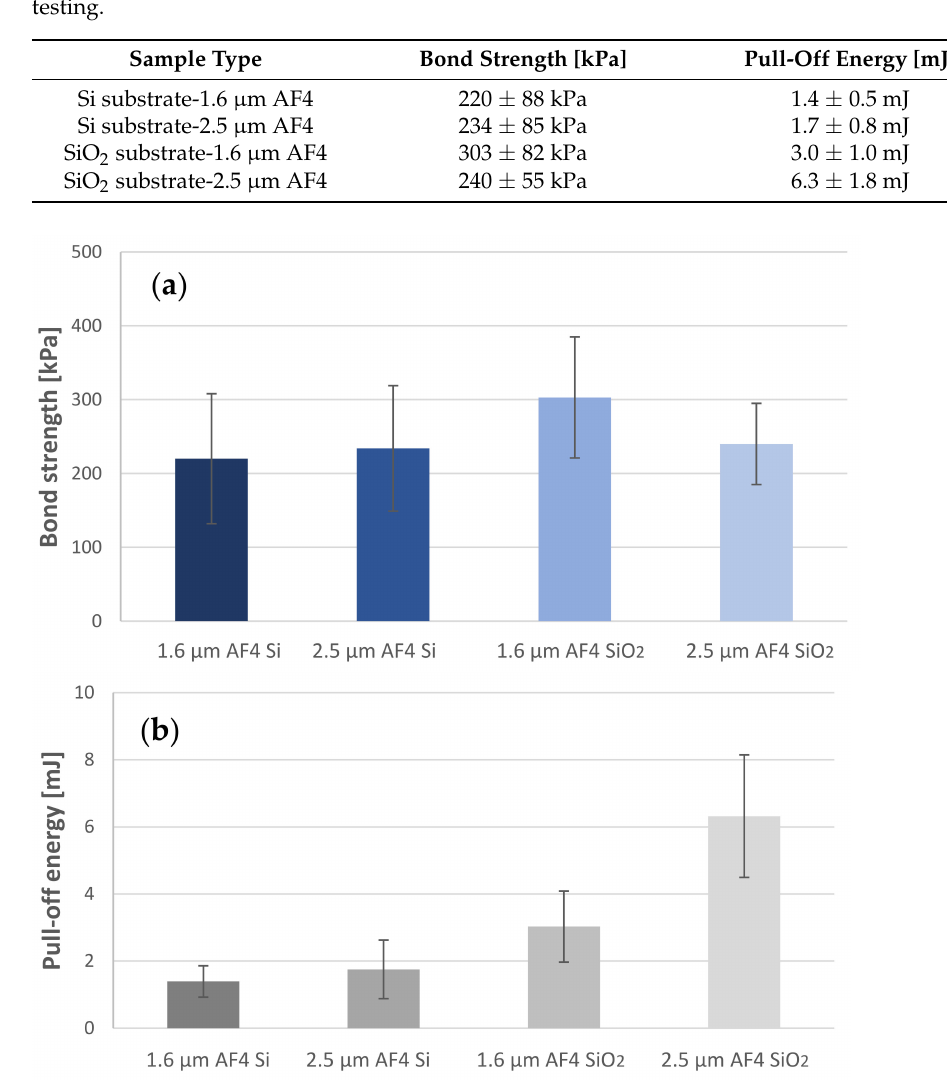
Figure 3. ( a ) Bond strengths and ( b ) pull-off energies for the different AF4 coatings presented in graphs from the data in Table